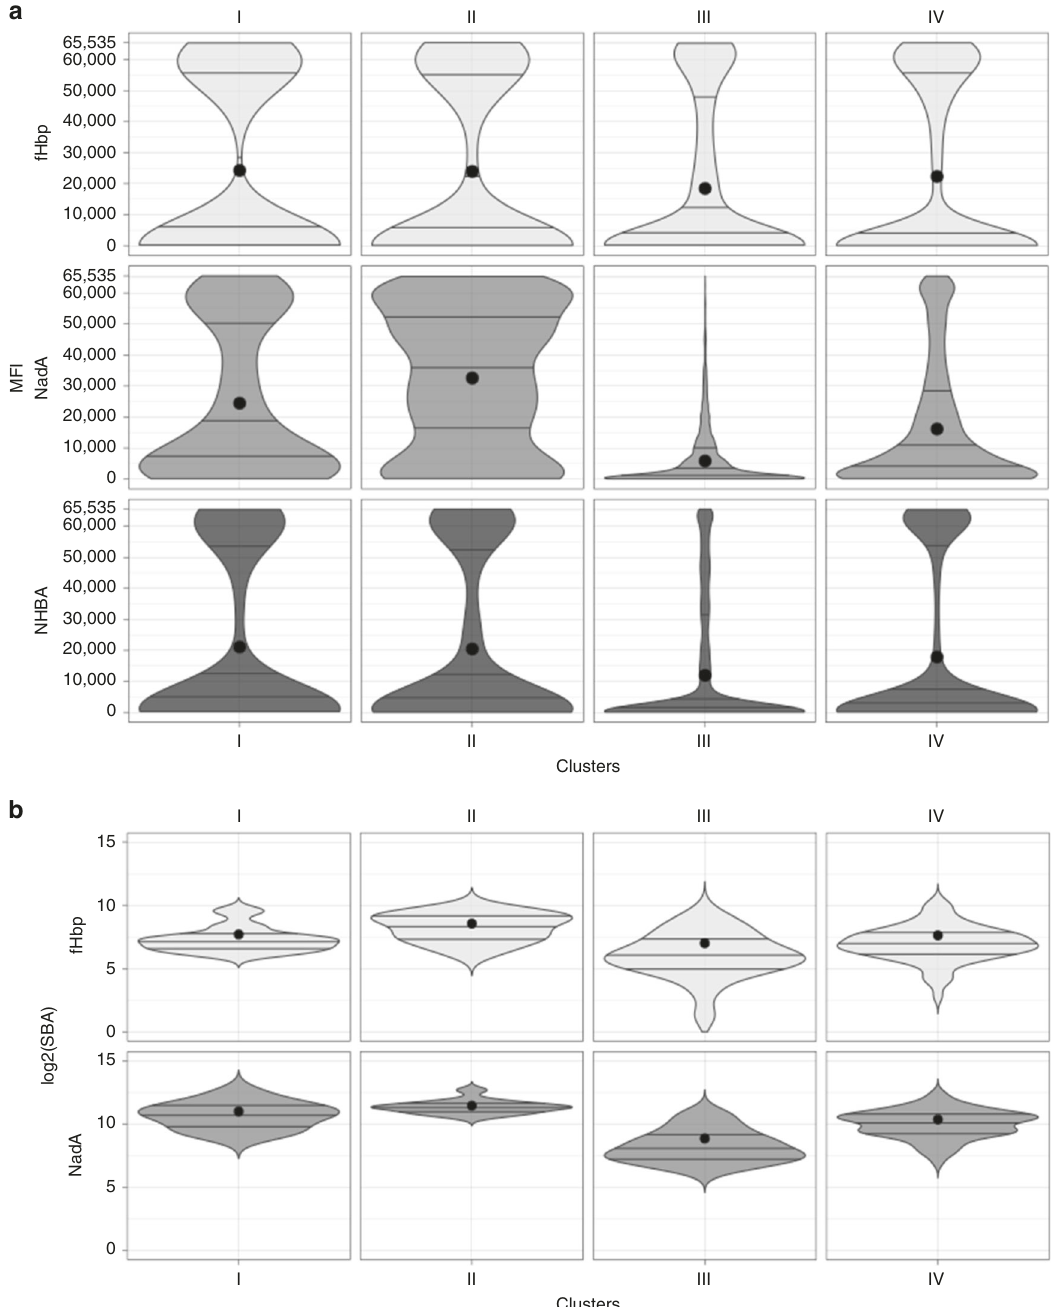
Fig. 4 Details of major clusters sera reactivity and functional activity. Panels a and b respectively represents violin plots of MFIs of all speci fi c antigen fragments and reference strain SBA titres available (vertical axes) in each of the four major clusters (horizontal axis). Black dots represent the mean of the distributions, while horizontal lines indicate quartiles. The wider sections of the violin plots represent a higher density in their data distributions, while the skinnier sections represent a lower density. § since the SBA data were not available for 11 subjects, the panel b violin plot for cluster III represents 7 infants, 12 adolescents and 23 adults; the plot for cluster IV represents 41 infants, 20 adolescents and 6